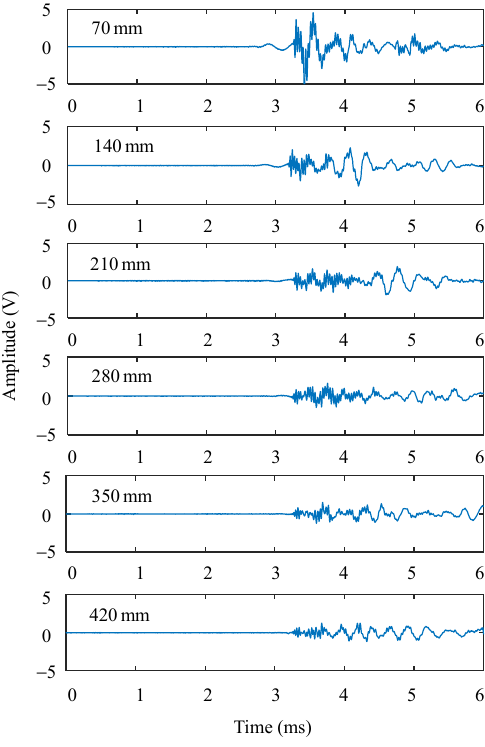
Fig. 4 Impact signals. Fig. 5 Frequency spectrum of impact